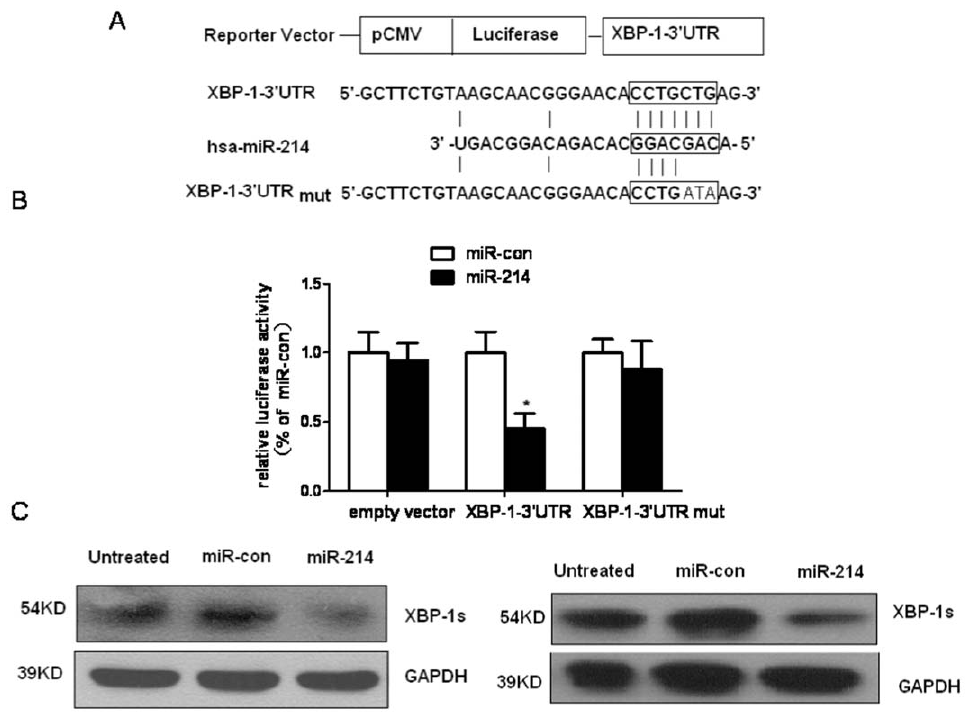
Figure 2. miR-214 negatively regulates XBP-1 through binding to 3 9 -UTR of the XBP-1. ( A ) Sequence alignment of human miR-214 with 3 9 -UTR of XBP-1. The seed sequence of miR-214 matches 3 9 -UTR of XBP-1 for creating the XBP-1 3 9 -UTR or mutant luciferase reporter construct. ( B ) miR-214 inhibits XBP-1 3 9 -UTR reporter but not mutant reporter or empty reporter activity. HepG2 cells were transiently transfected with indicated plasmids with miR-control, miR-214 mimics. Following 36 h of incubation, cells were subjected to luciferase assay. Columns, mean of three independent experiments; bars, SD. * P , 0.05 vs miR-con. ( C ) miR-214 reduces XBP-1 expression in HepG2 (left) and SMMC-7721(right) cells analyzed by western